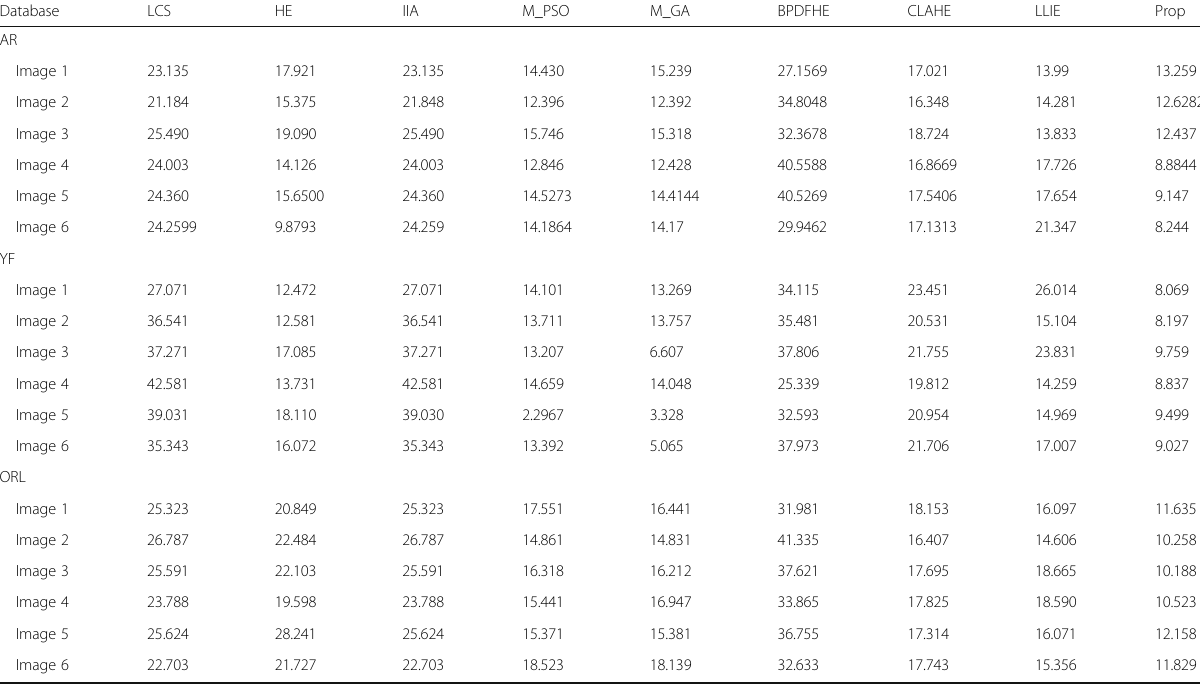
Table 6 Peak signal-to-noise ratio value comparison between results obtained using different enhancement methods on three different standard benchmark face datasets